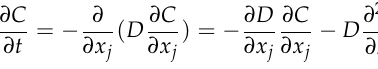
Figure 11. Ensemble averaged plume trajectory (over 500 neutrally buoyant particles of each size) for the case with no turbulence effect and thus with pure advection. Release location was at x 1 ∈ [ 2.5, 3 ] m, x 2 = 1.10